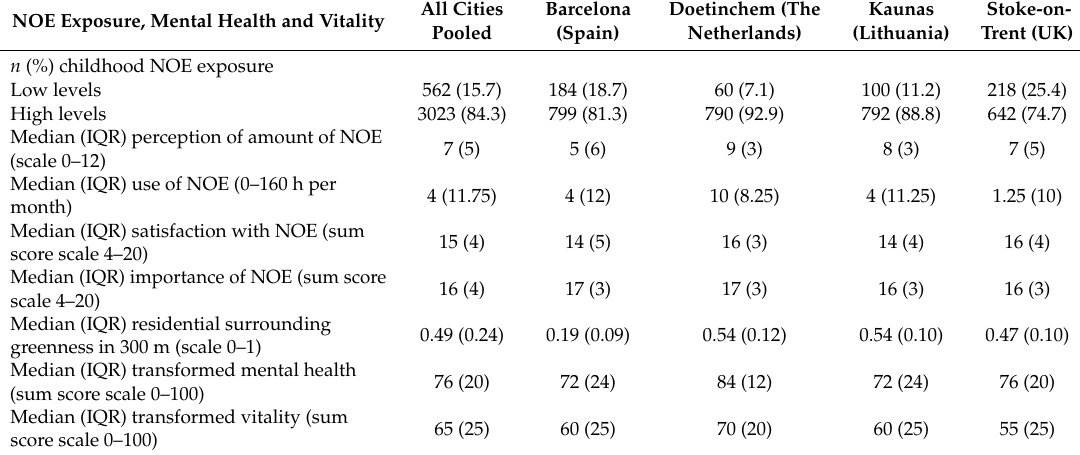
Table 3. NOE exposure, mental health and vitality of the study population: pooled and city-specific analyses. NOE Exposure, Mental Health and